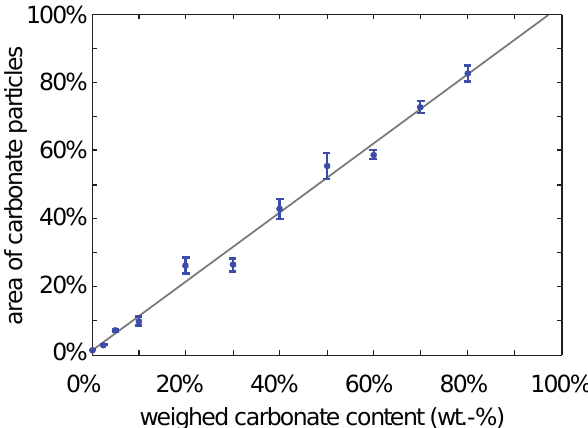
Fig. 3. Example of a dust sequence of core De3 showing a detected east wind layer (gray bar) during the late LGM with a silt sized carbonate content greater than 2% and a probability of dust greater than 70%. The eolian transported carbonate particles of such layers are of the same mean size as the corresponding quartz